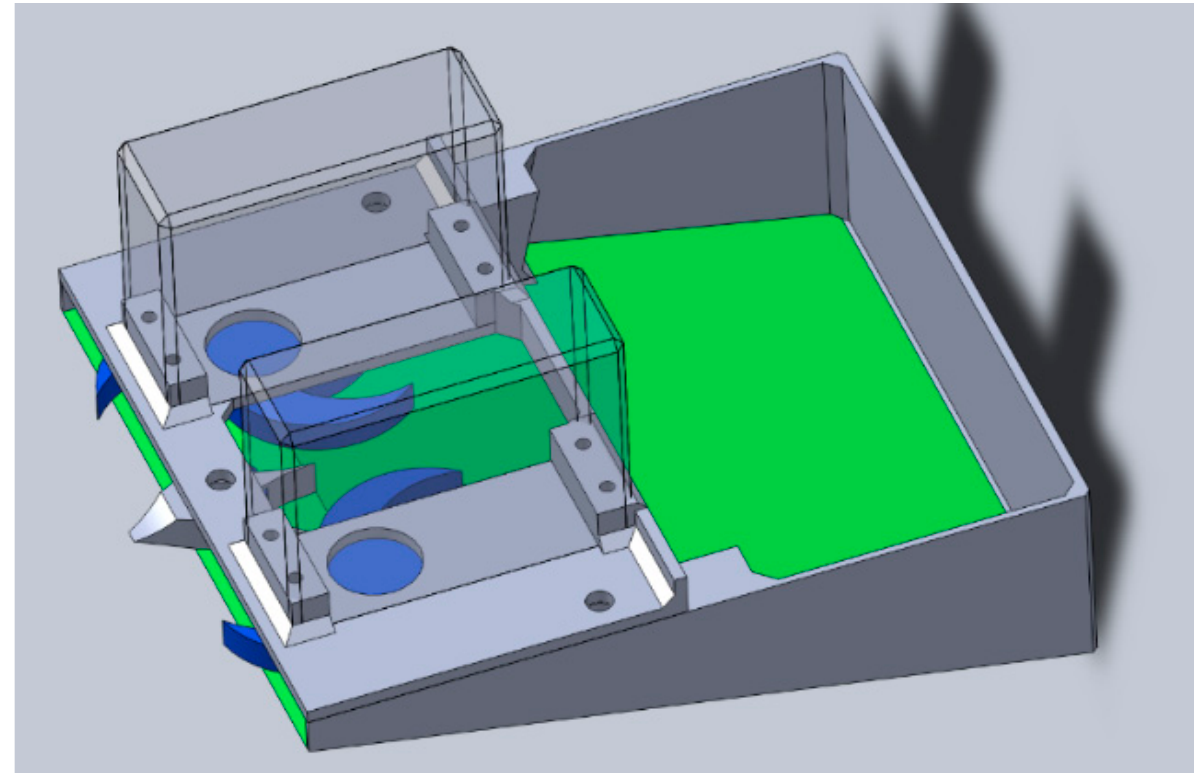
Figure 1. Hypothetical regolith harvesting machine CAD model.